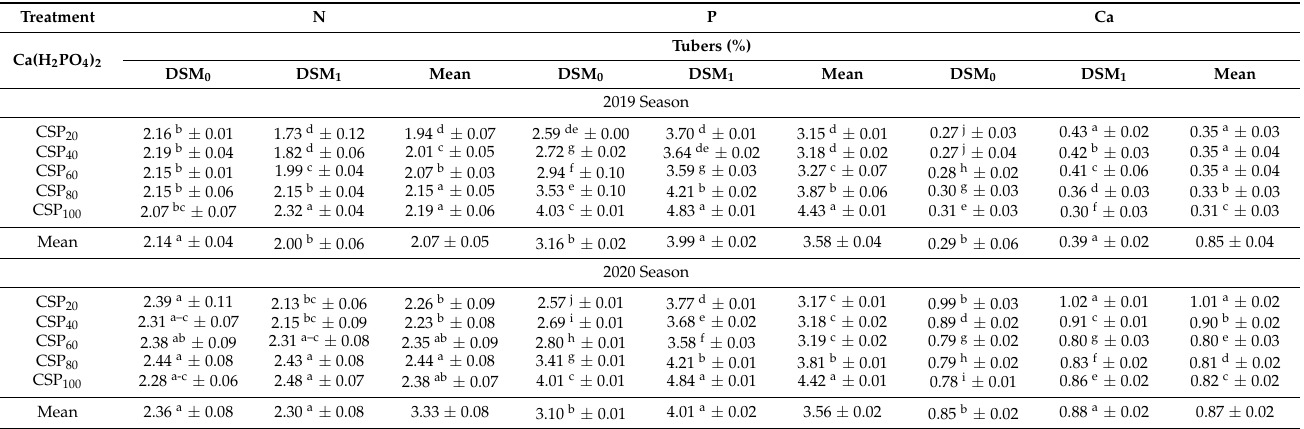
Table 6. Influence of phosphorus fertilizer, Bacillus megaterium DSM 2894 var. and their interactions on some tuber nutrients accumulation of CaCO 3 -stressed sweet potato plants in 2019 and